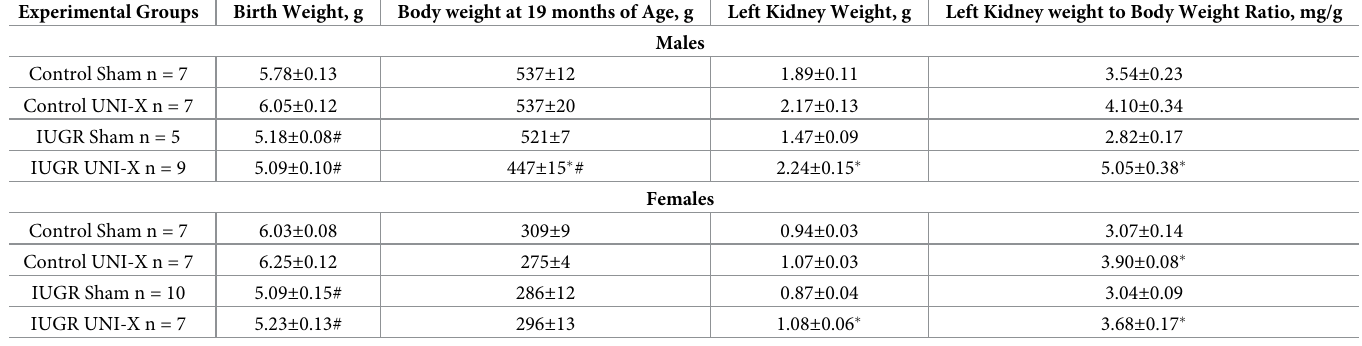
Table 1. Group characteristics: Birth weight, body weight, and kidney weight. Experimental